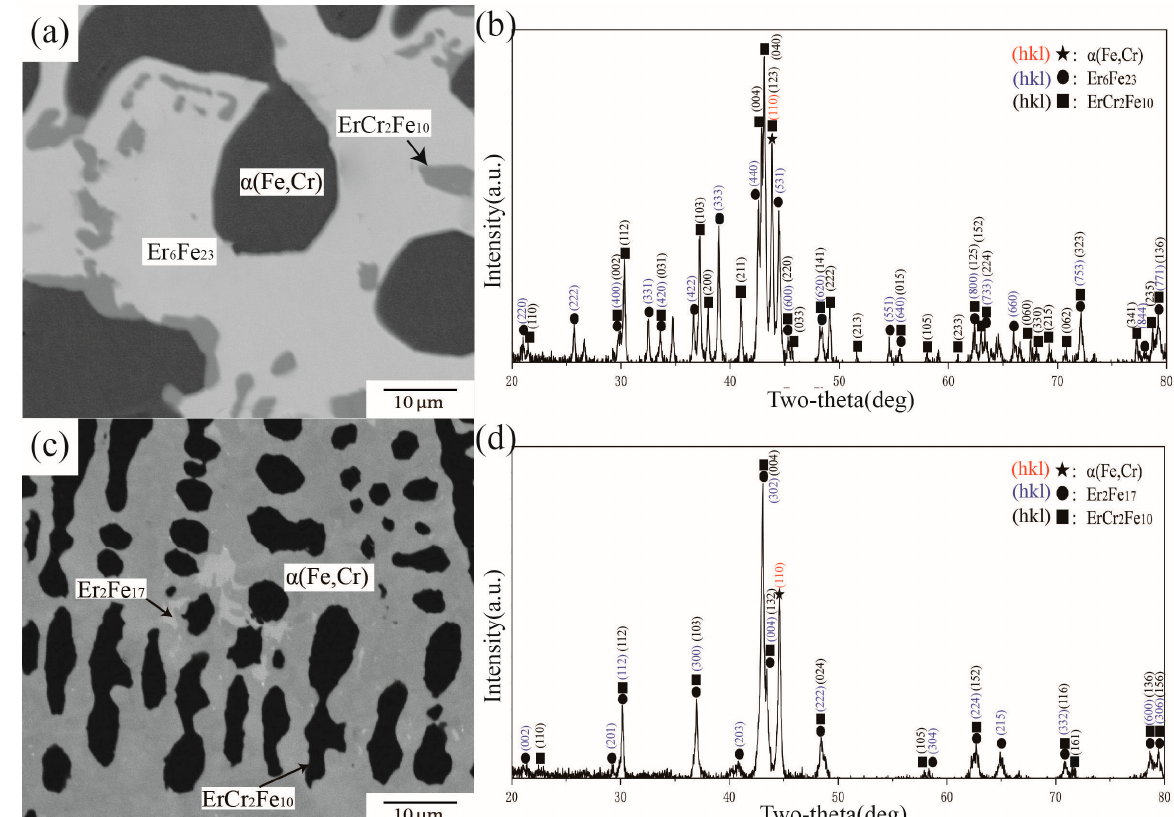
Figure 12. ( a ) BSE image of alloy B8, ( b ) XRD result of alloy B8, ( c ) BSE image of alloy B11, ( d ) XRD result of alloy B11.